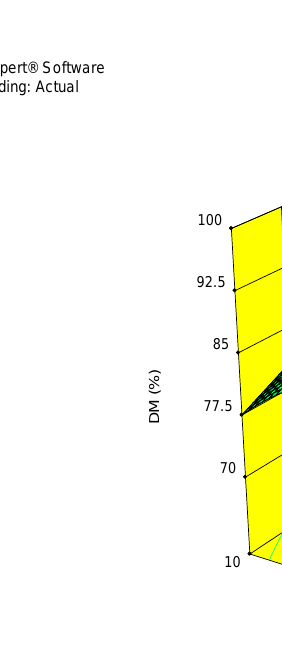
Figure 7. Dry matter (DM) of pulp detoxified with the pilot vibro-fluidized bed under different treatment conditions.